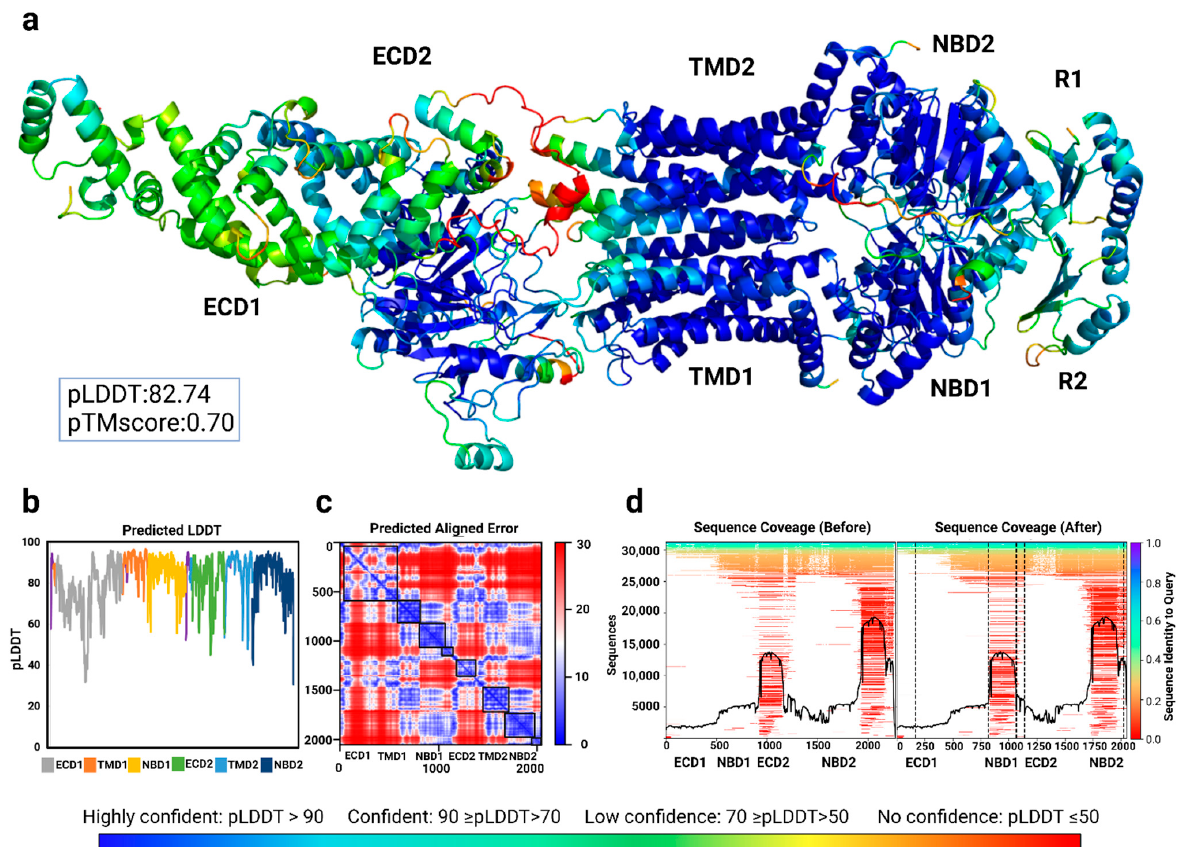
Figure 1. Confidence and quality of the full-length WT ABCA4 AlplaFold2 model generated in the ColabFold. ( a ) ABCA4 WT model colored based on the pLDDT (predicted Local Distance Difference Test) score in PyMol2. ( b ) Scatter plot illustrating the residual pLDDT. ( c ) Predicted aligned error (PAE), demonstrating the expected distance error in Å, which helps assess the confidence of the relative positions and the domain structures. ABCA4 domains are shown in black